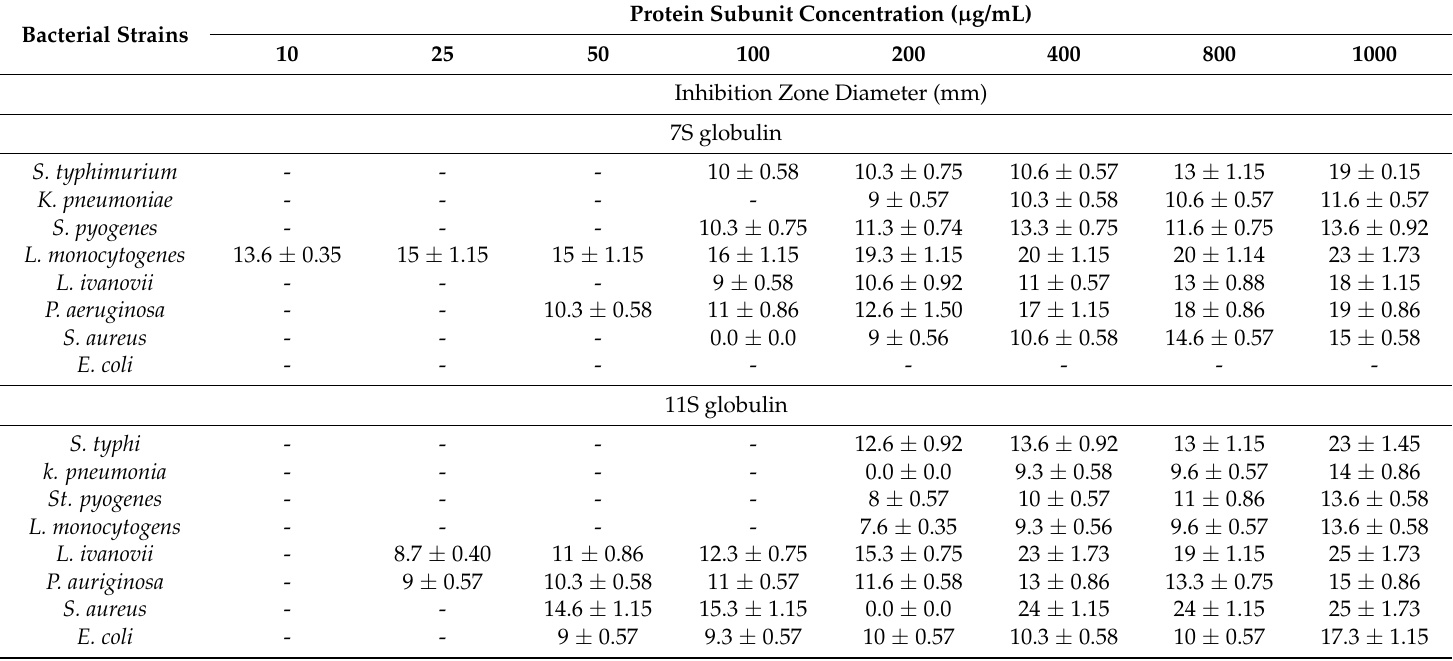
Table 1. Antibacterial activity of 7S and 11S globulins at different concentrations against different pathogenic bacteria. Bacterial